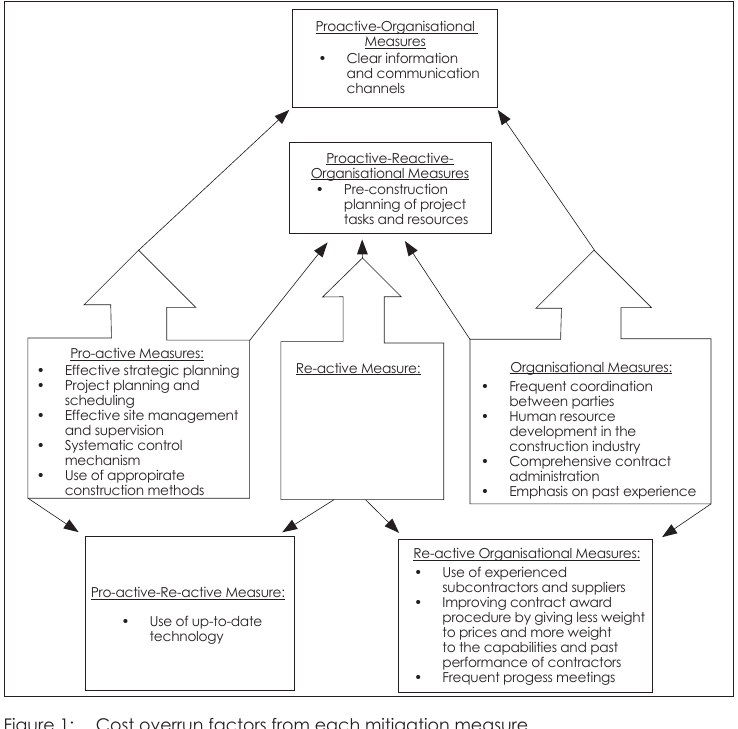
Figure 1: Cost overrun factors from each mitigation measure